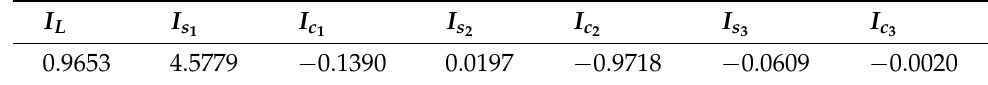
Table 5. Amplitudes of reference signals.